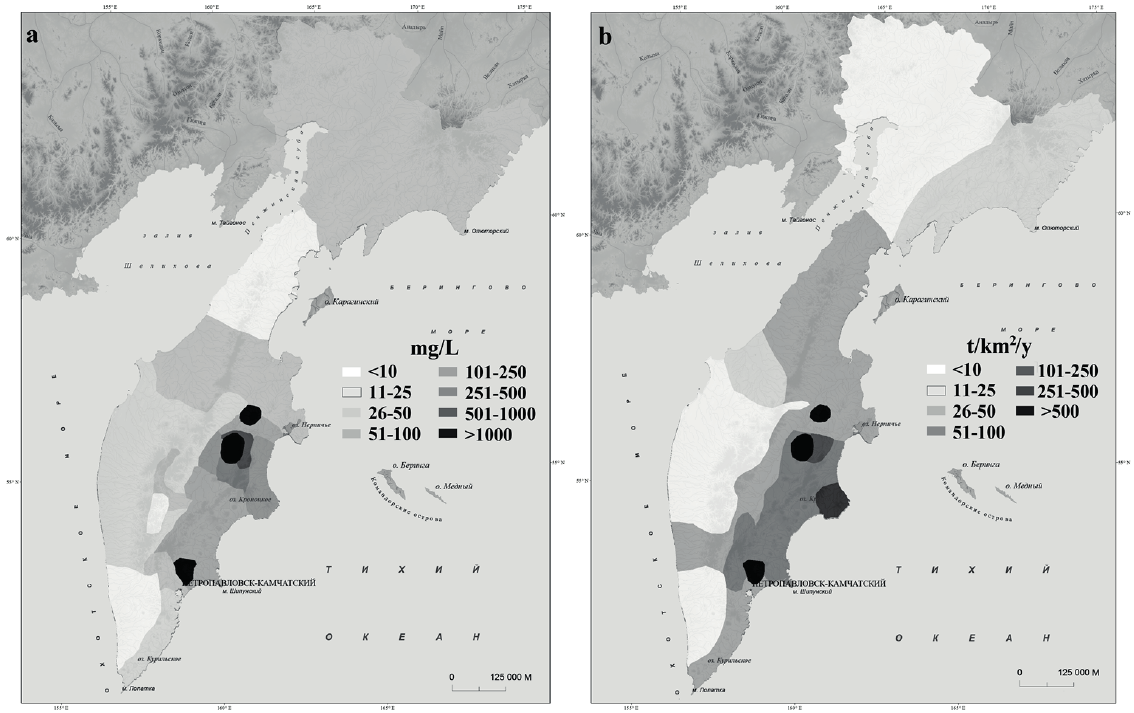
Fig. 5 Suspended sediment concentration (a) and specific sediment yield (b) in the Kamchatka